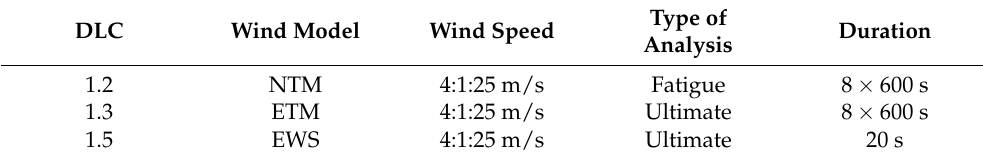
Table A4. Design load cases evaluated in this appendix.